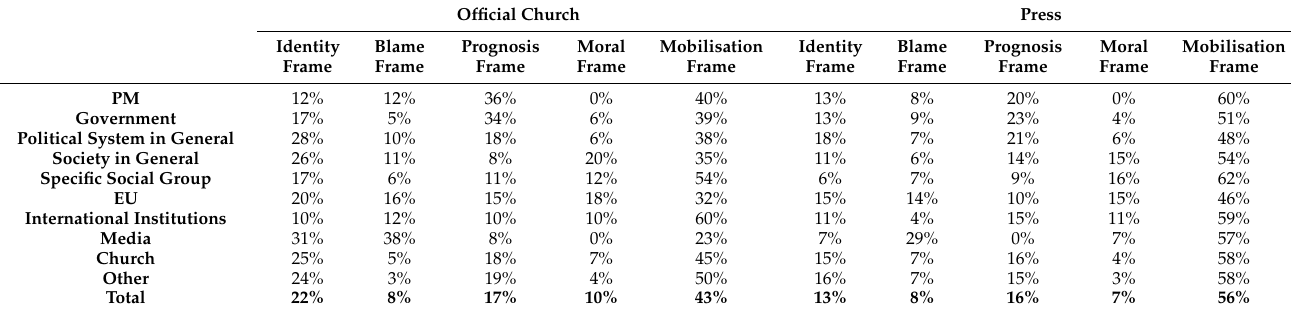
Table 2. Framing per